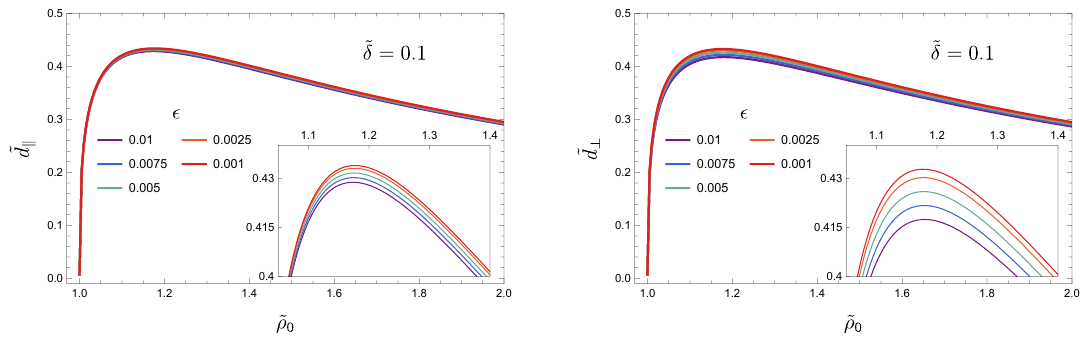
= π T d and ˜ d ⊥ = π T d ⊥ versus the turning point ˜ ρ 0 = ρ 0 k k